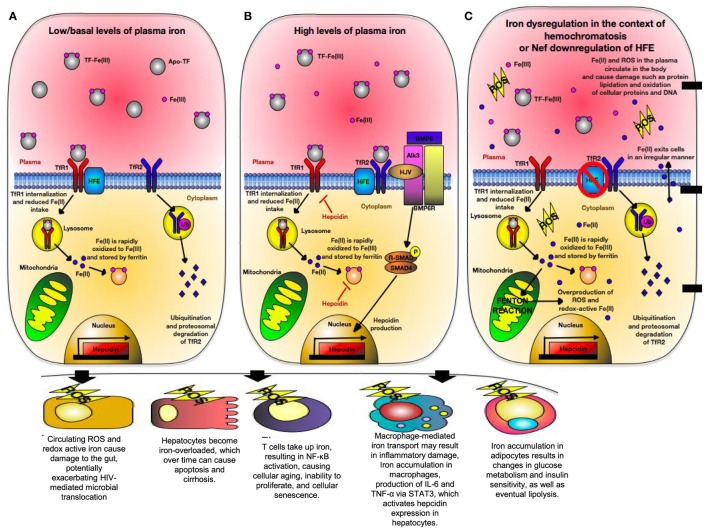
Iron regulation of hepatocytes during normal physiological condition versus conditions of hereditary hemochromatosis (HH) or human immunodeficiency virus (HIV) infection. (A) Under normal physiological iron concentration, transferrin-bound iron is taken up upon binding of saturated transferrin to transferrin receptor 1 (TfR1), which is endocytosed and recycled. Fe(III) (indicated in pink) is oxidized to Fe(II) (indicated in blue) in the endosome and is reduced back to Fe(III). Fe(III) then is stored intracellularly by ferritin. TfR1 and transferrin receptor 2 (TfR2) are in competition for High Fe (HFE). When not associated with HFE, TfR2 is endocytosed, ubiquitinated, and thus degraded by the proteasome. This maintains uptake of iron into the hepatocyte. (B) When too much iron is present in the plasma, HFE interacts with TfR2, preventing its ubiquitination. A multiprotein complex consisting of HFE, GPI-anchor HJV, and TfR2 form on the hepatocyte membrane. HJV is the bone morphogenic protein (BMP) co-receptor, which assists in activating hepcidin gene expression via BMP/SMAD signaling. Hepcidin then limits cellular iron intake by promoting degradation of cellular ferritin, as well as downregulating TfR1 expression. (C) In situations where HFE is absent (i.e., HIV or certain mutations in HFE), TfR2 is unable to interact with HFE and is thus degraded. In states of high physiological iron, TfR2 is unable to mediate hepcidin gene expression. Due to this, cells become iron overloaded labile cell iron (LCI) and non-transferrin-bound labile plasma iron (LPI). These forms of redox-active iron are able to move across cell membranes in a non-regular manner. LCI participates in a Fenton reaction, resulting in overproduction of reactive oxygen species (ROS) that cause lipid peroxidation, protein nitration, and DNA damage. LPI is able to enter other cells irregularly, thus causing even more production of ROS. Eventually, hepcidin production will be triggered due to STAT3 signaling caused by ROS-induced inflammation.